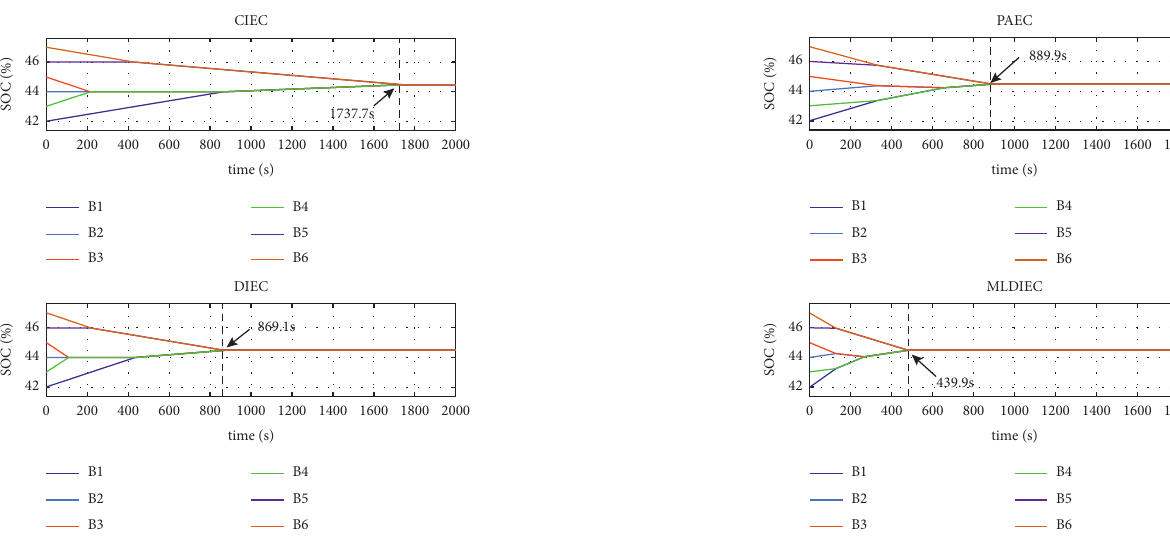
Table 3: Equalization results of the four equalizing circuits in the standing state.